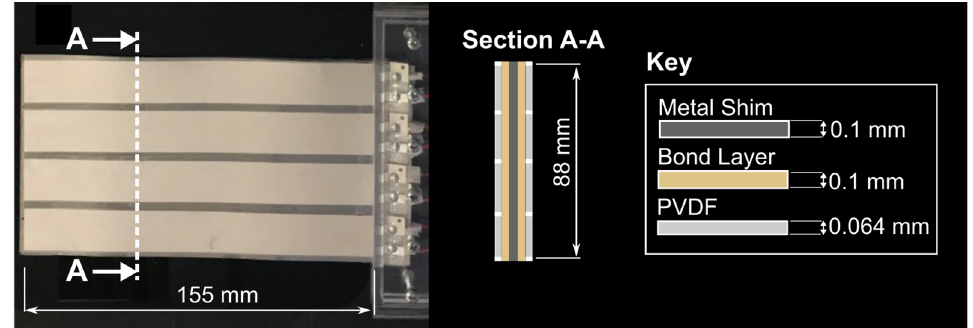
Figure 1. Structural configuration of the piezoelectric inverted flag (the wind flows left-to-right). Note the Perspex clamp, which is designed to provide a cantilever boundary condition at the flag root.